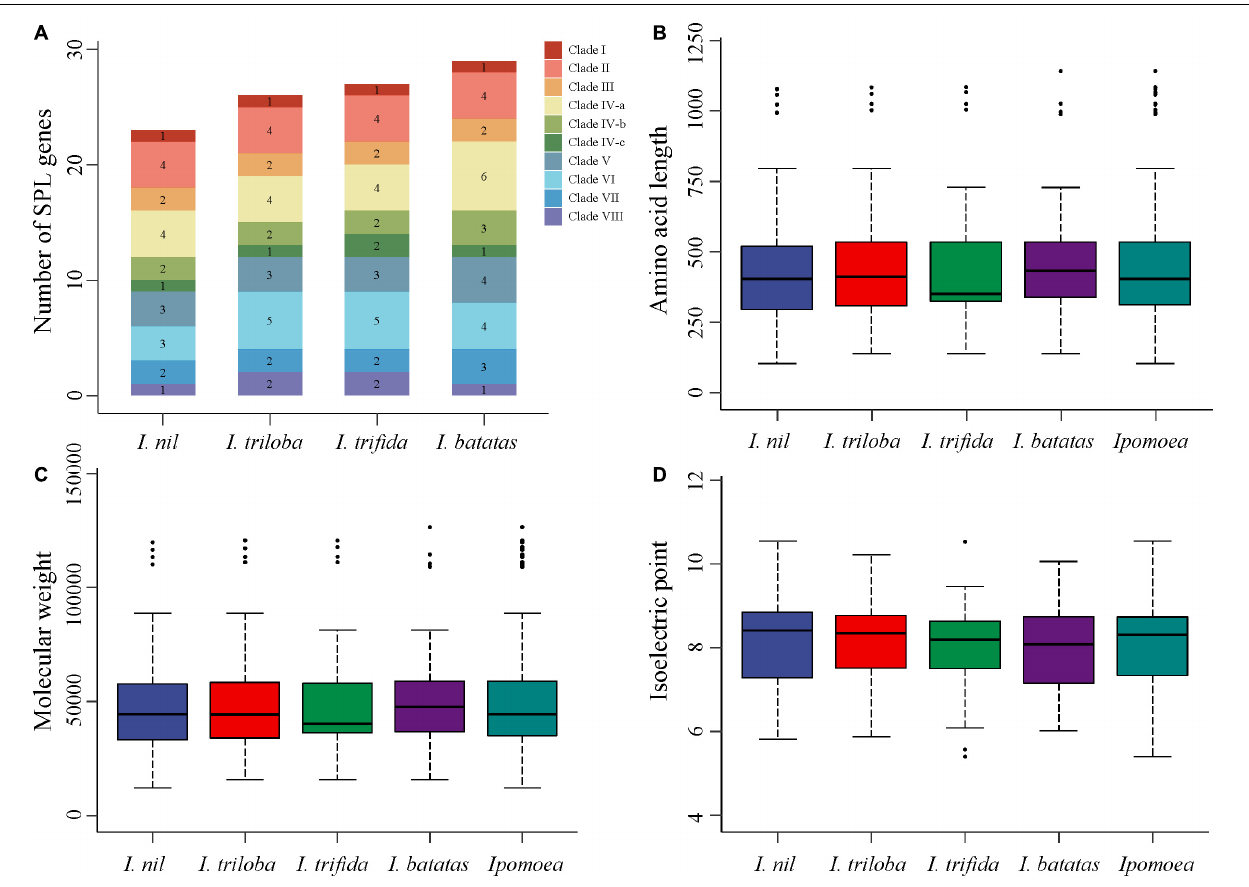
FIGURE 1 | Comparison of SPL genes in four Ipomoea species. (A) Comparison of the number and ratio of SPL genes in four Ipomoea species, with different colors representing each clade. (B–D) Comparison of SPL protein lengths, MWs, and pIs in four Ipomoea species, respectively.